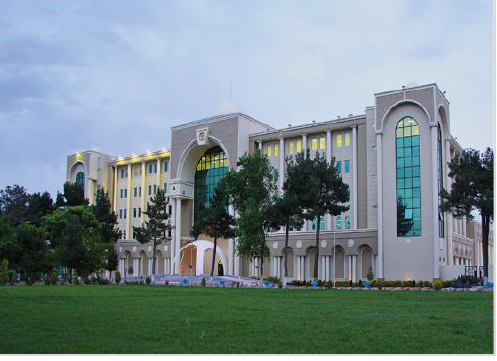
Figure 15 Photograph illustrating the front view Ministry of national defense designed with mixed western and Islamic architectural styles in Kabul city (Scheuer,